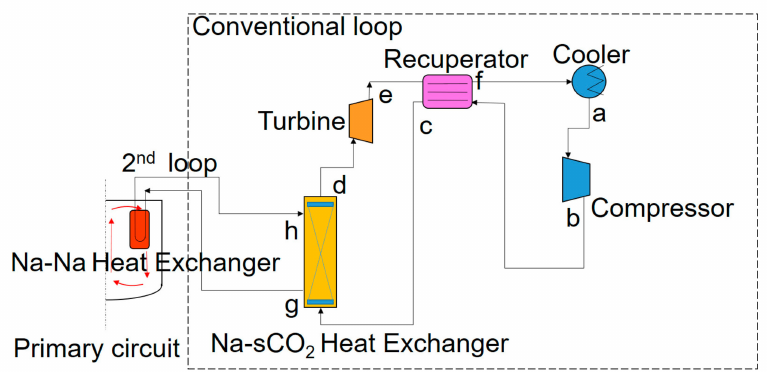
Figure 1. Layouts of the SFR-sCO 2 recuperation cycle. a–h represent state points of working fluid in the